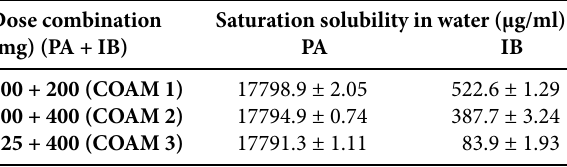
Table 1. Saturation solubility of PA and IB in COAM in various dose combinations Dose combination